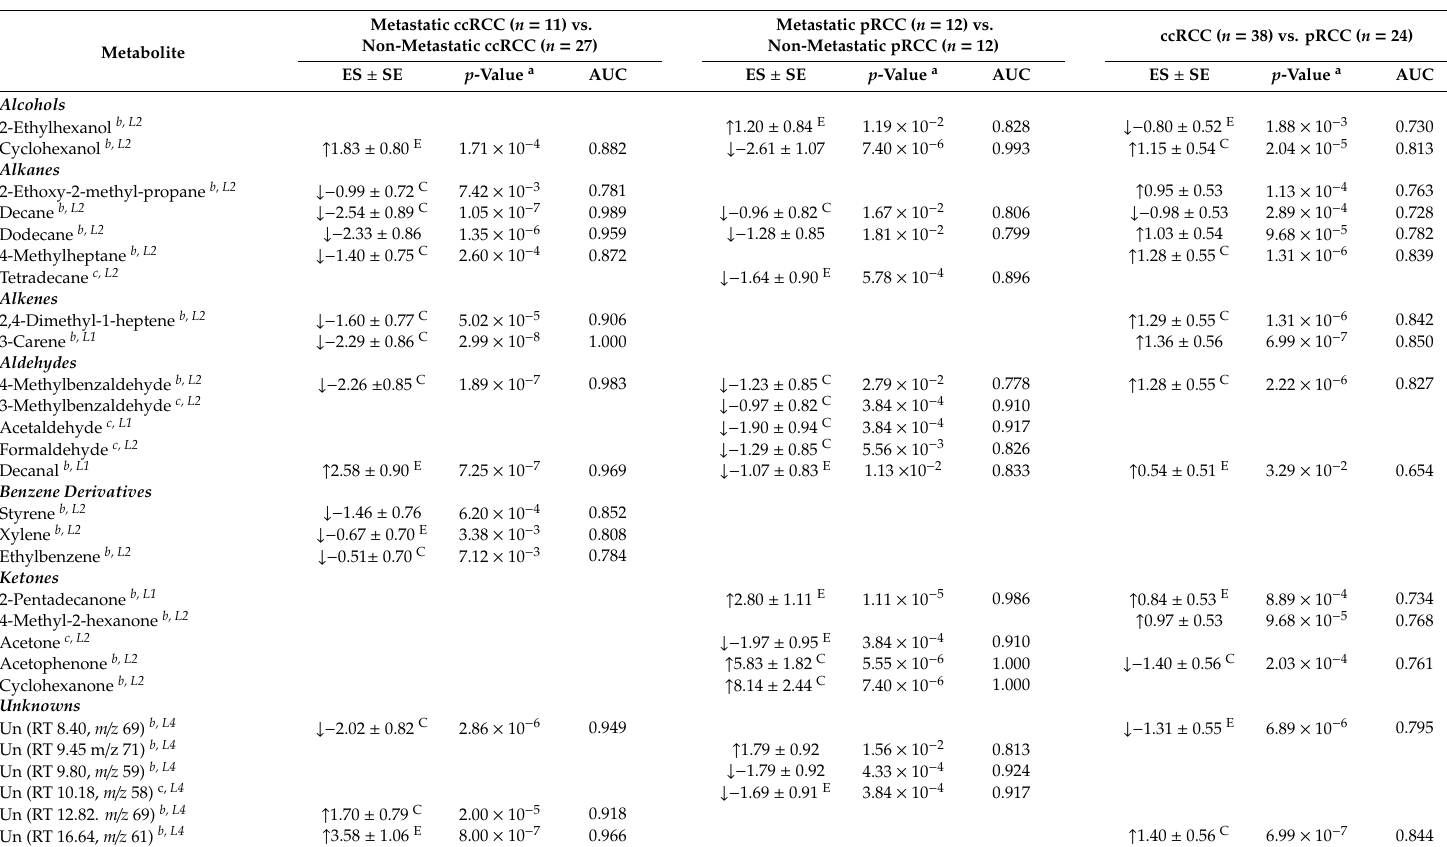
Table 3. List of volatile compounds (VOCs and VCCs) significantly altered between metastatic cell lines compared with non-metastatic cell lines and between RCC histological subtype (ccRCC and